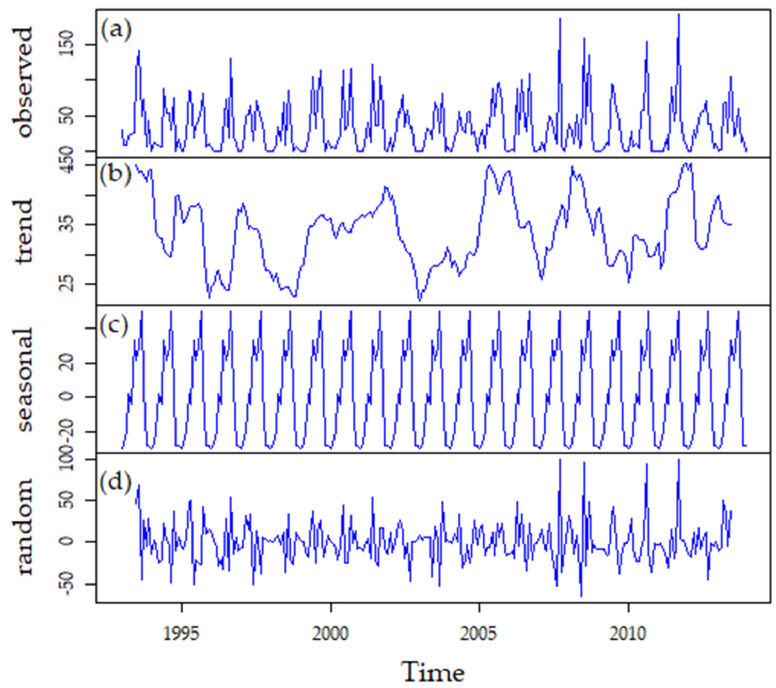
Figure 4. Decomposition of additive time series of monthly rainfall values recorded at the SMN weather station 21,052 (1993 to 2013). The observed data is represented in the upper panel ( a ), while the next panels show the additive components [( b ) long-term trend, ( c ) seasonal, and ( d ) random components]. There was a statistically significant decreasing trend in the monthly evaporation values from 1993 to 2013 ( − 0.14, p < 0.05). Higher evaporation values occurred in 1996 and from then on, evapora- tion decreased gradually until 2000 (Figure 5). Evaporation increased in 2001 and 2002, and from 2002 on, it decreased and sustained similar low values until 2013. There were statistically significant nega- tive trends for the evaporation values of November ( r = − 1.73, p < 0.05), December ( r = − 1.39, p < 0.05), and January ( r = − 1.92, p < 0.05). The monthly evaporation values correlated positively with the PDO index ( r = 0.30, p < 0.05).